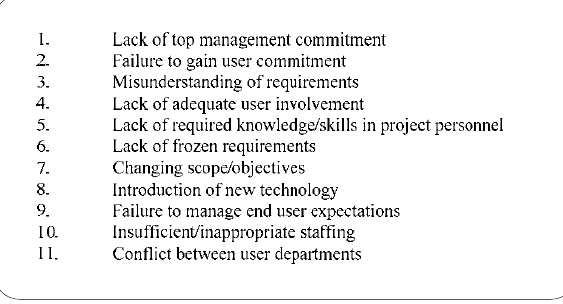
Figure 5: Schmidt et al’s (2001) ‘top eleven’ software risk